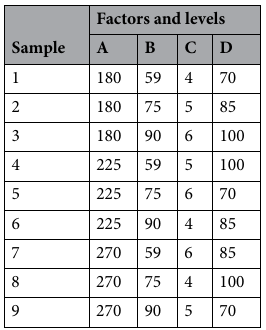
Table 3. Taguchi L 9 ortoghonal